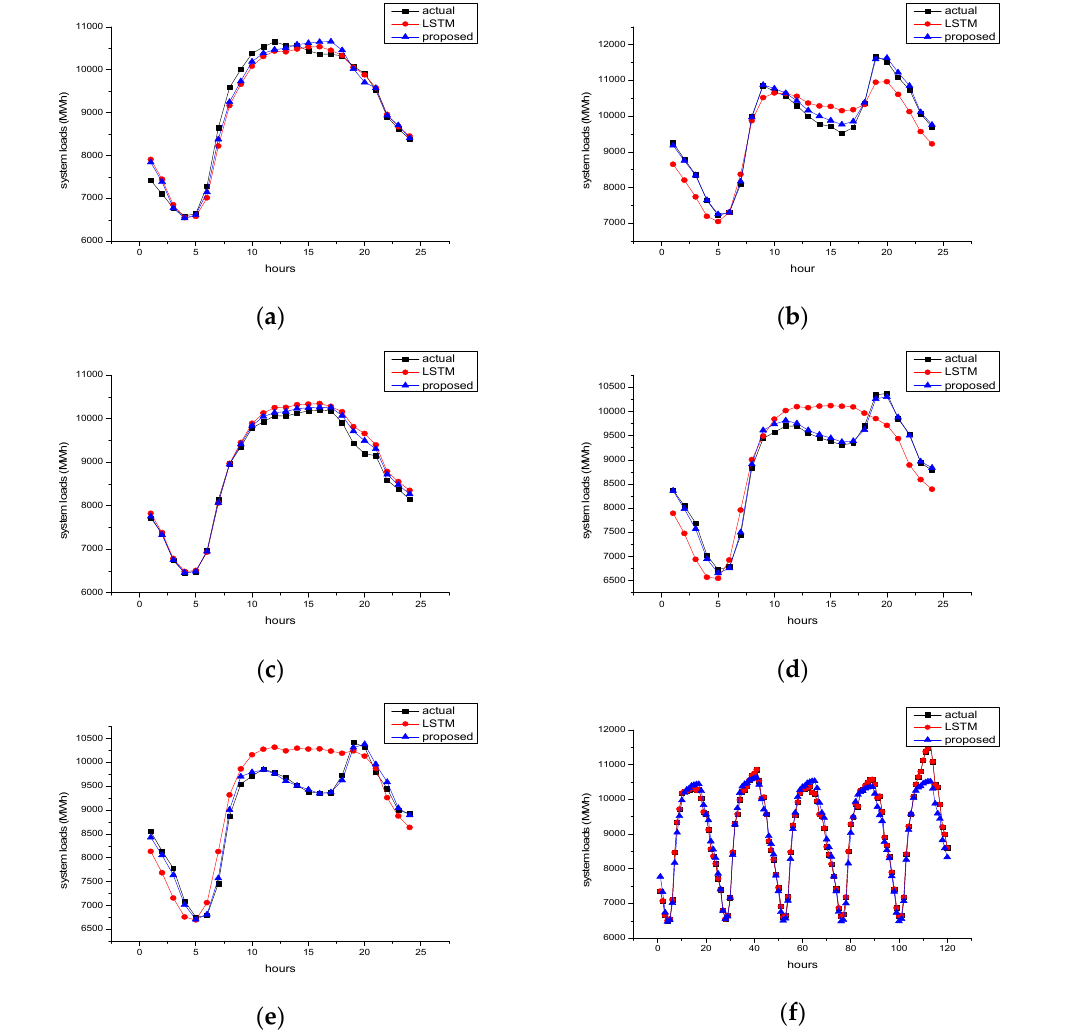
Figure 7. Forecast results for ( a ) 29 March 2010, Monday; ( b ) 8 June 2010, Tuesday; ( c ) 24 November 2010, Wednesday; ( d ) 2 September 2010, Thursday; ( e ) 3 September 2010, Friday; ( f ) the week from 22 March (Monday) to 26 March (Friday) 2010.